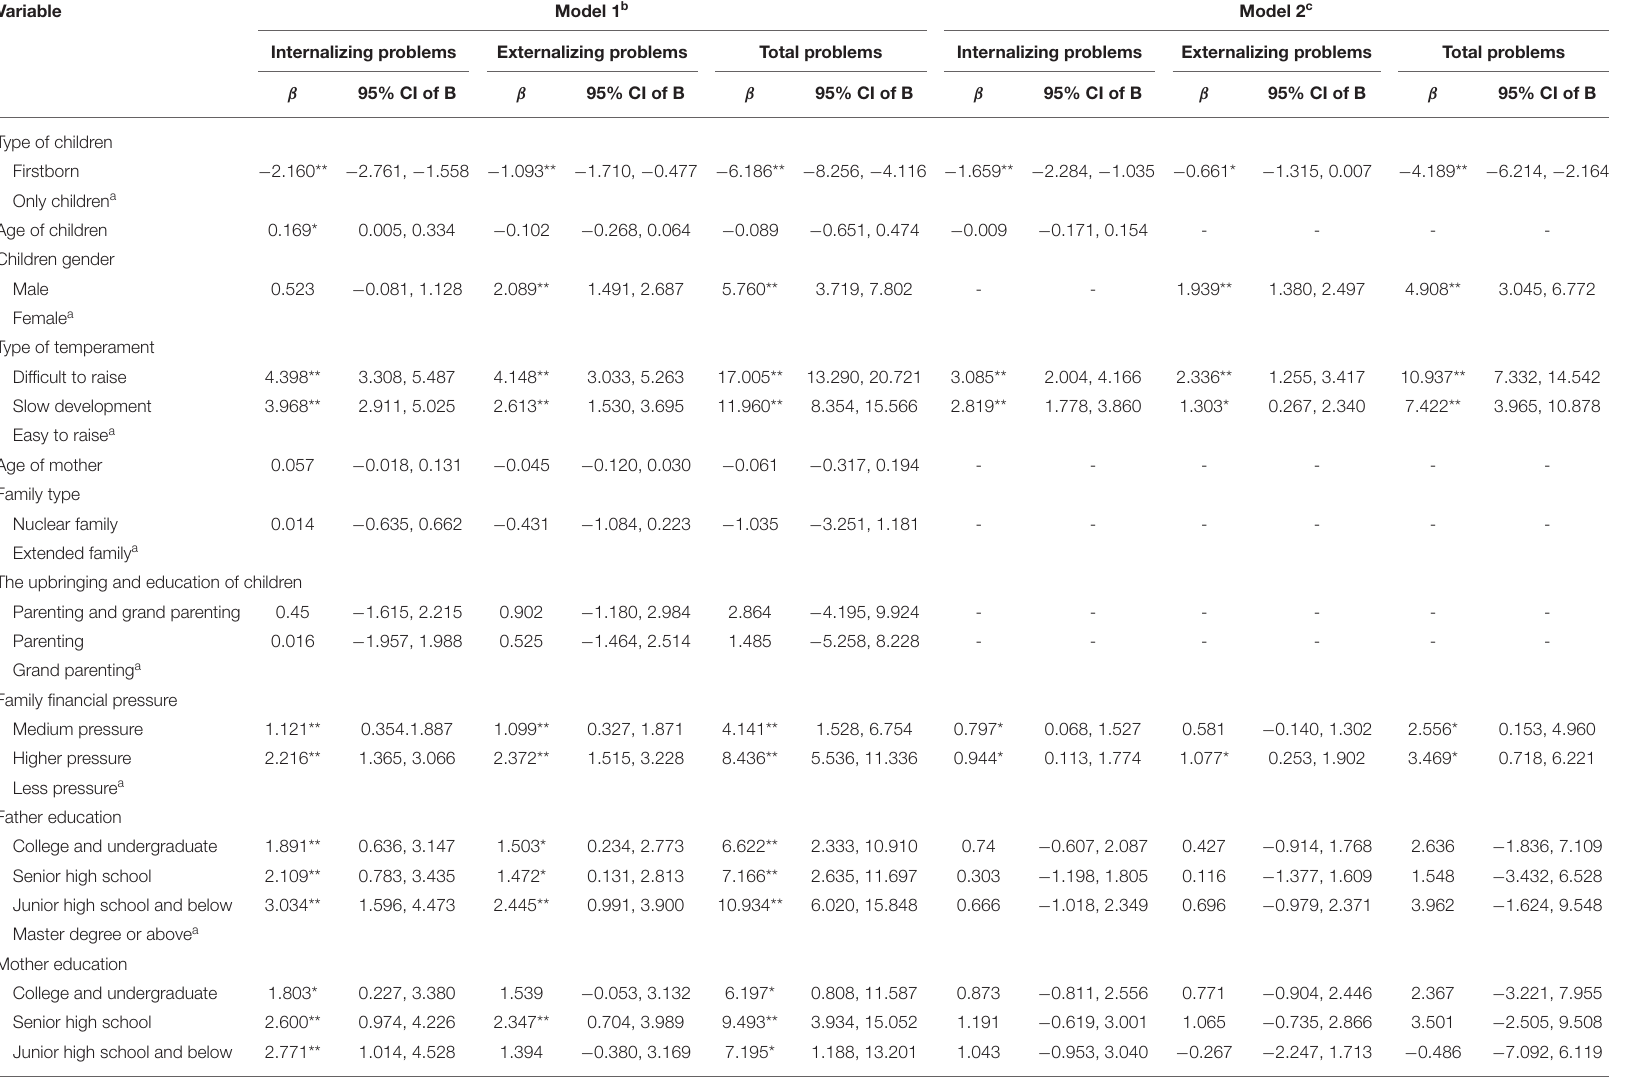
TABLE 3 | Simple and multiple linear regression on emotional and behavior problems of all children